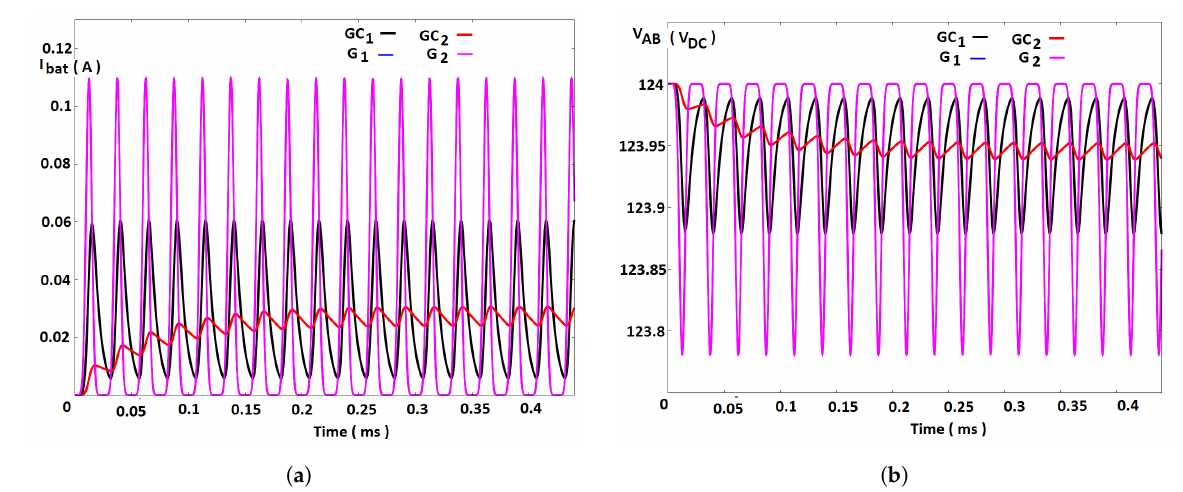
Figure 7. Case II. ( a ) Battery current. ( b ) Voltage V AB